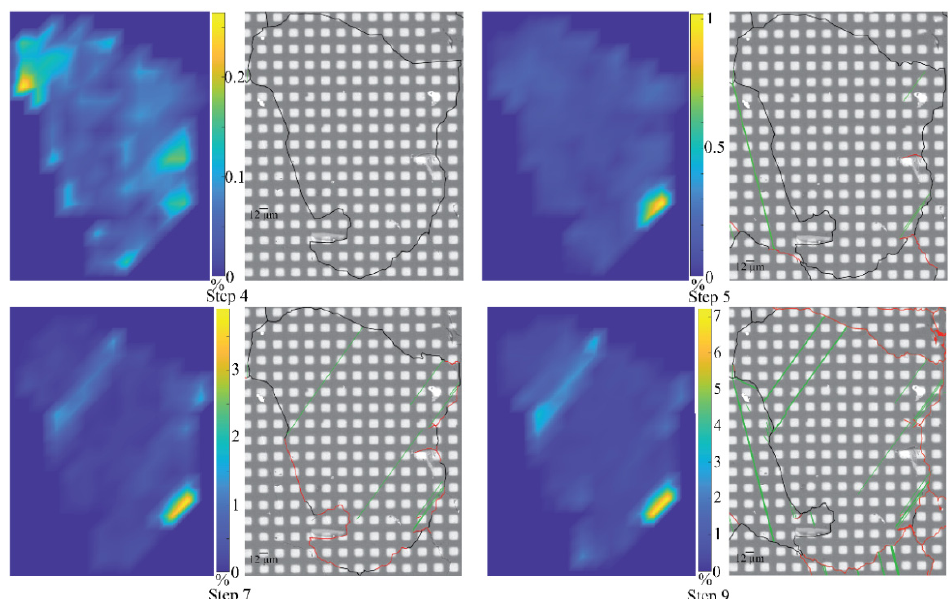
Figure 15. Equivalent Von Mises deformation map of crystal 8 at different steps of sample deformation. The black lines represent the grain boundaries. The green lines show the twinned planes. The red lines show the fracture zones.